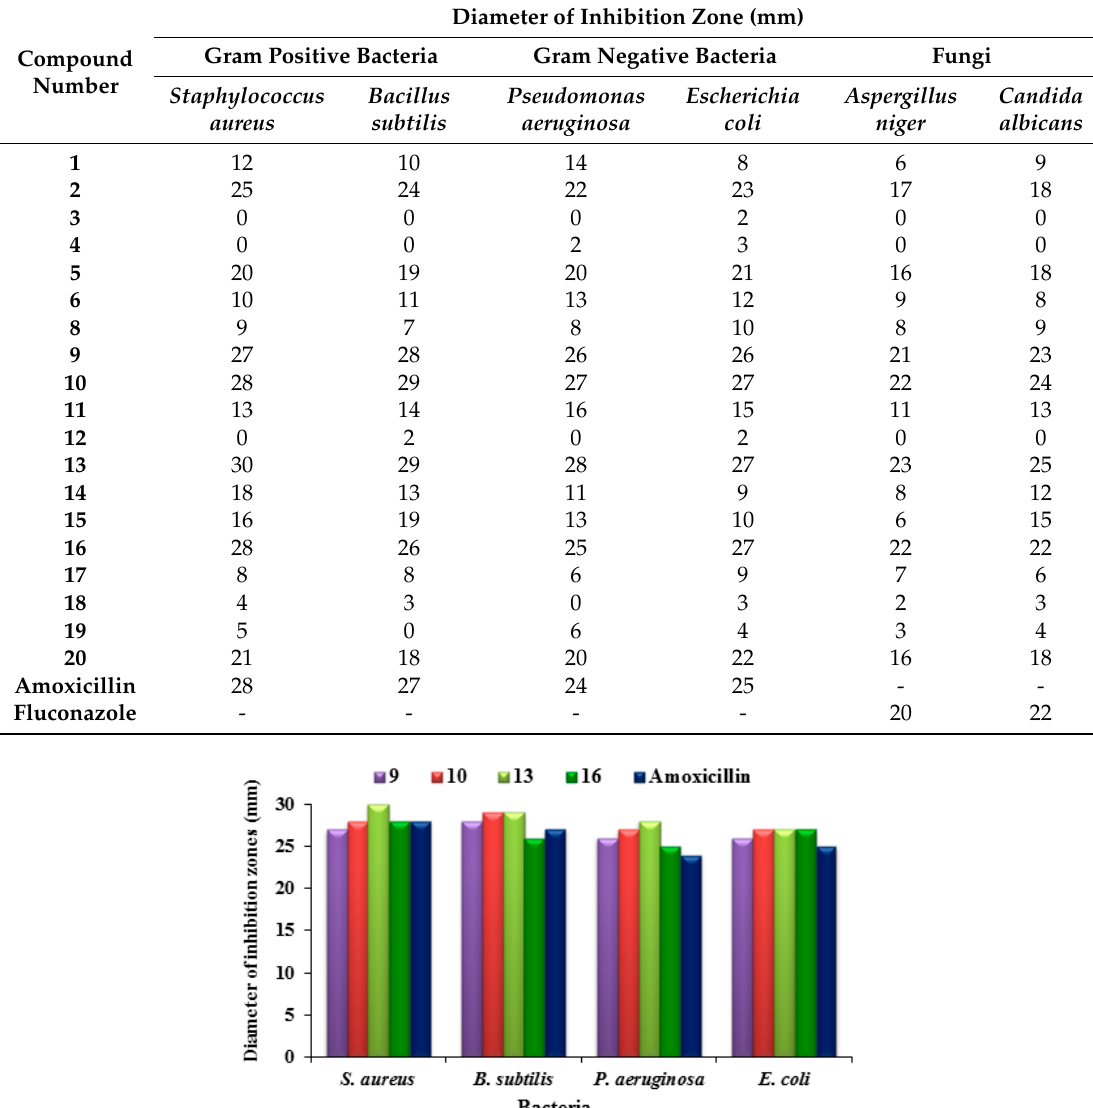
Table 1. In vitro antimicrobial activities of the tested compounds 1 – 20 at 100 µg/mL and expressed as inhibition zone diameter (mm).